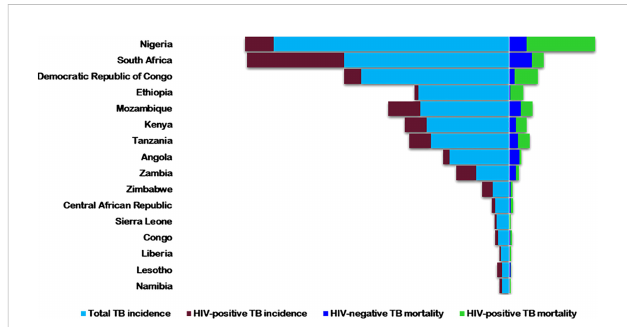
FIGURE 1 The 2018 estimated rates of HIV+/-TB incidence and mortality in the highest TB/HIV buden countries in Africa. Rates are per 100,000 populations [World Health Organization, Globa; Tuberculosis Report